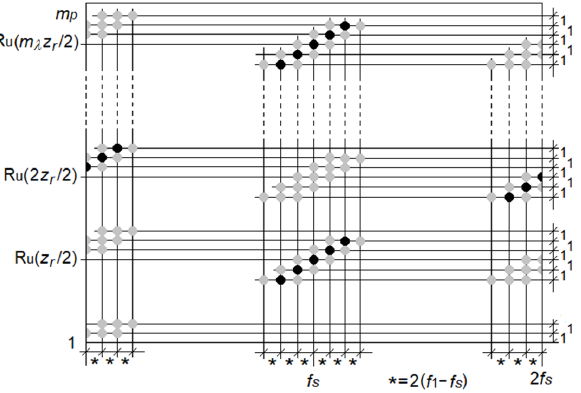
Figure 3. Reference F-F image pattern associated with toothed rotor structure origin radial force of electrical machine with air gap and flow dissymmetry.